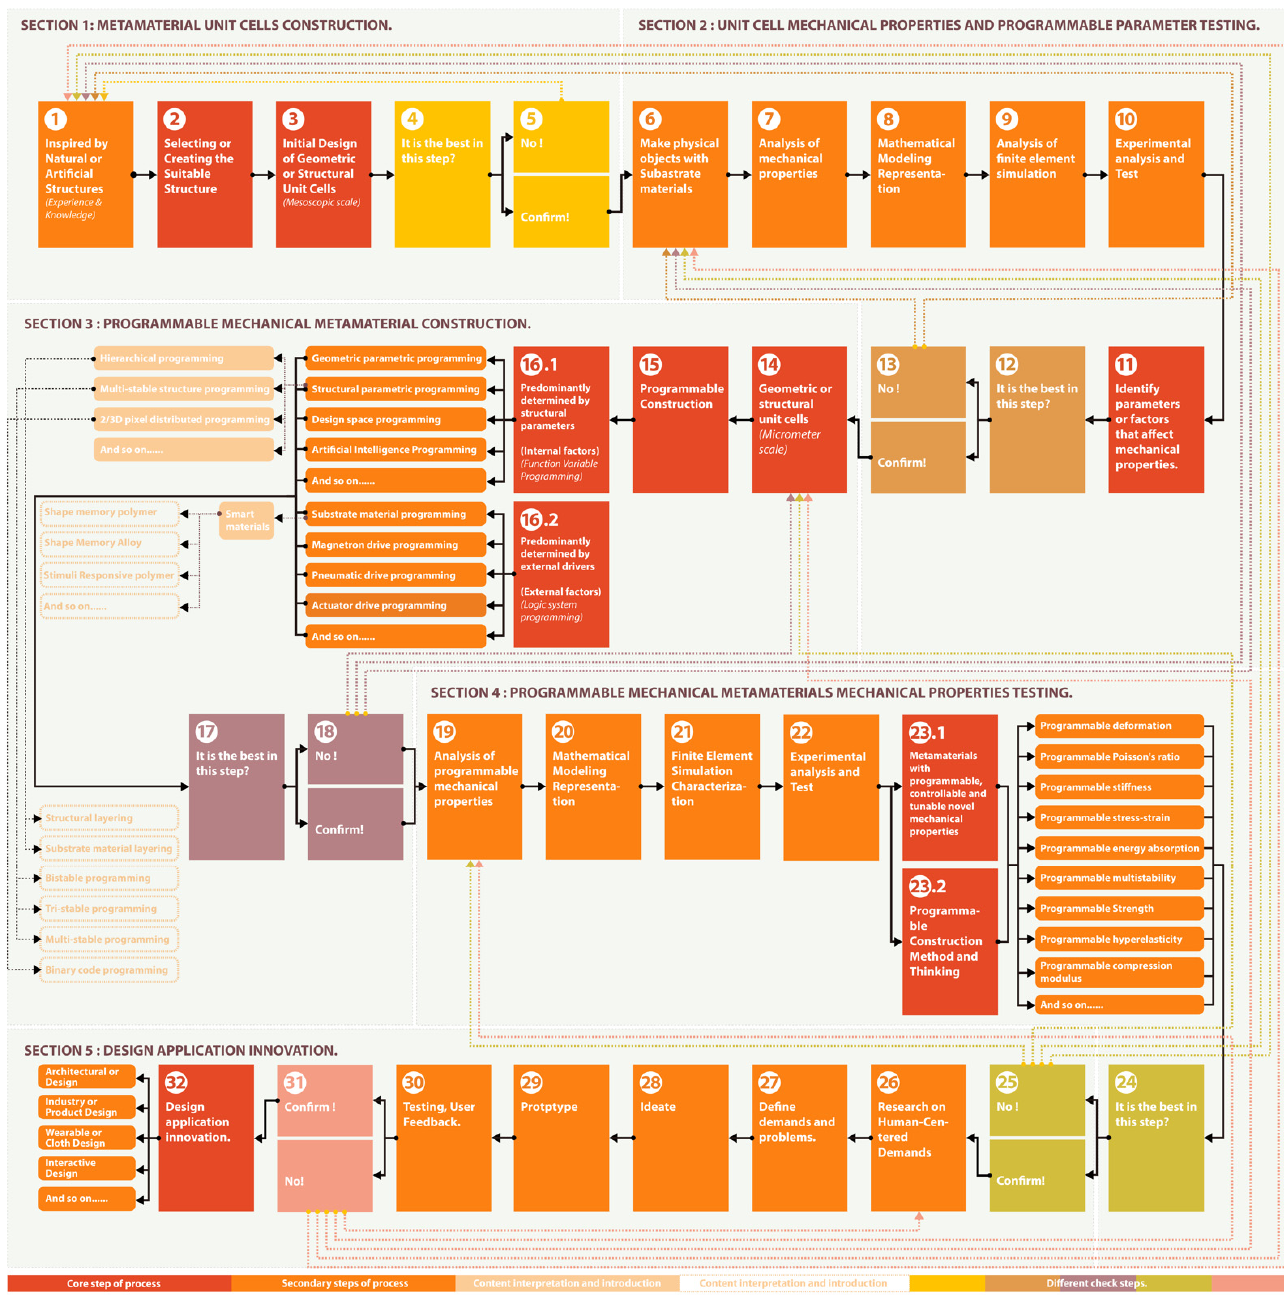
Figure 9. IDMPMM process model.